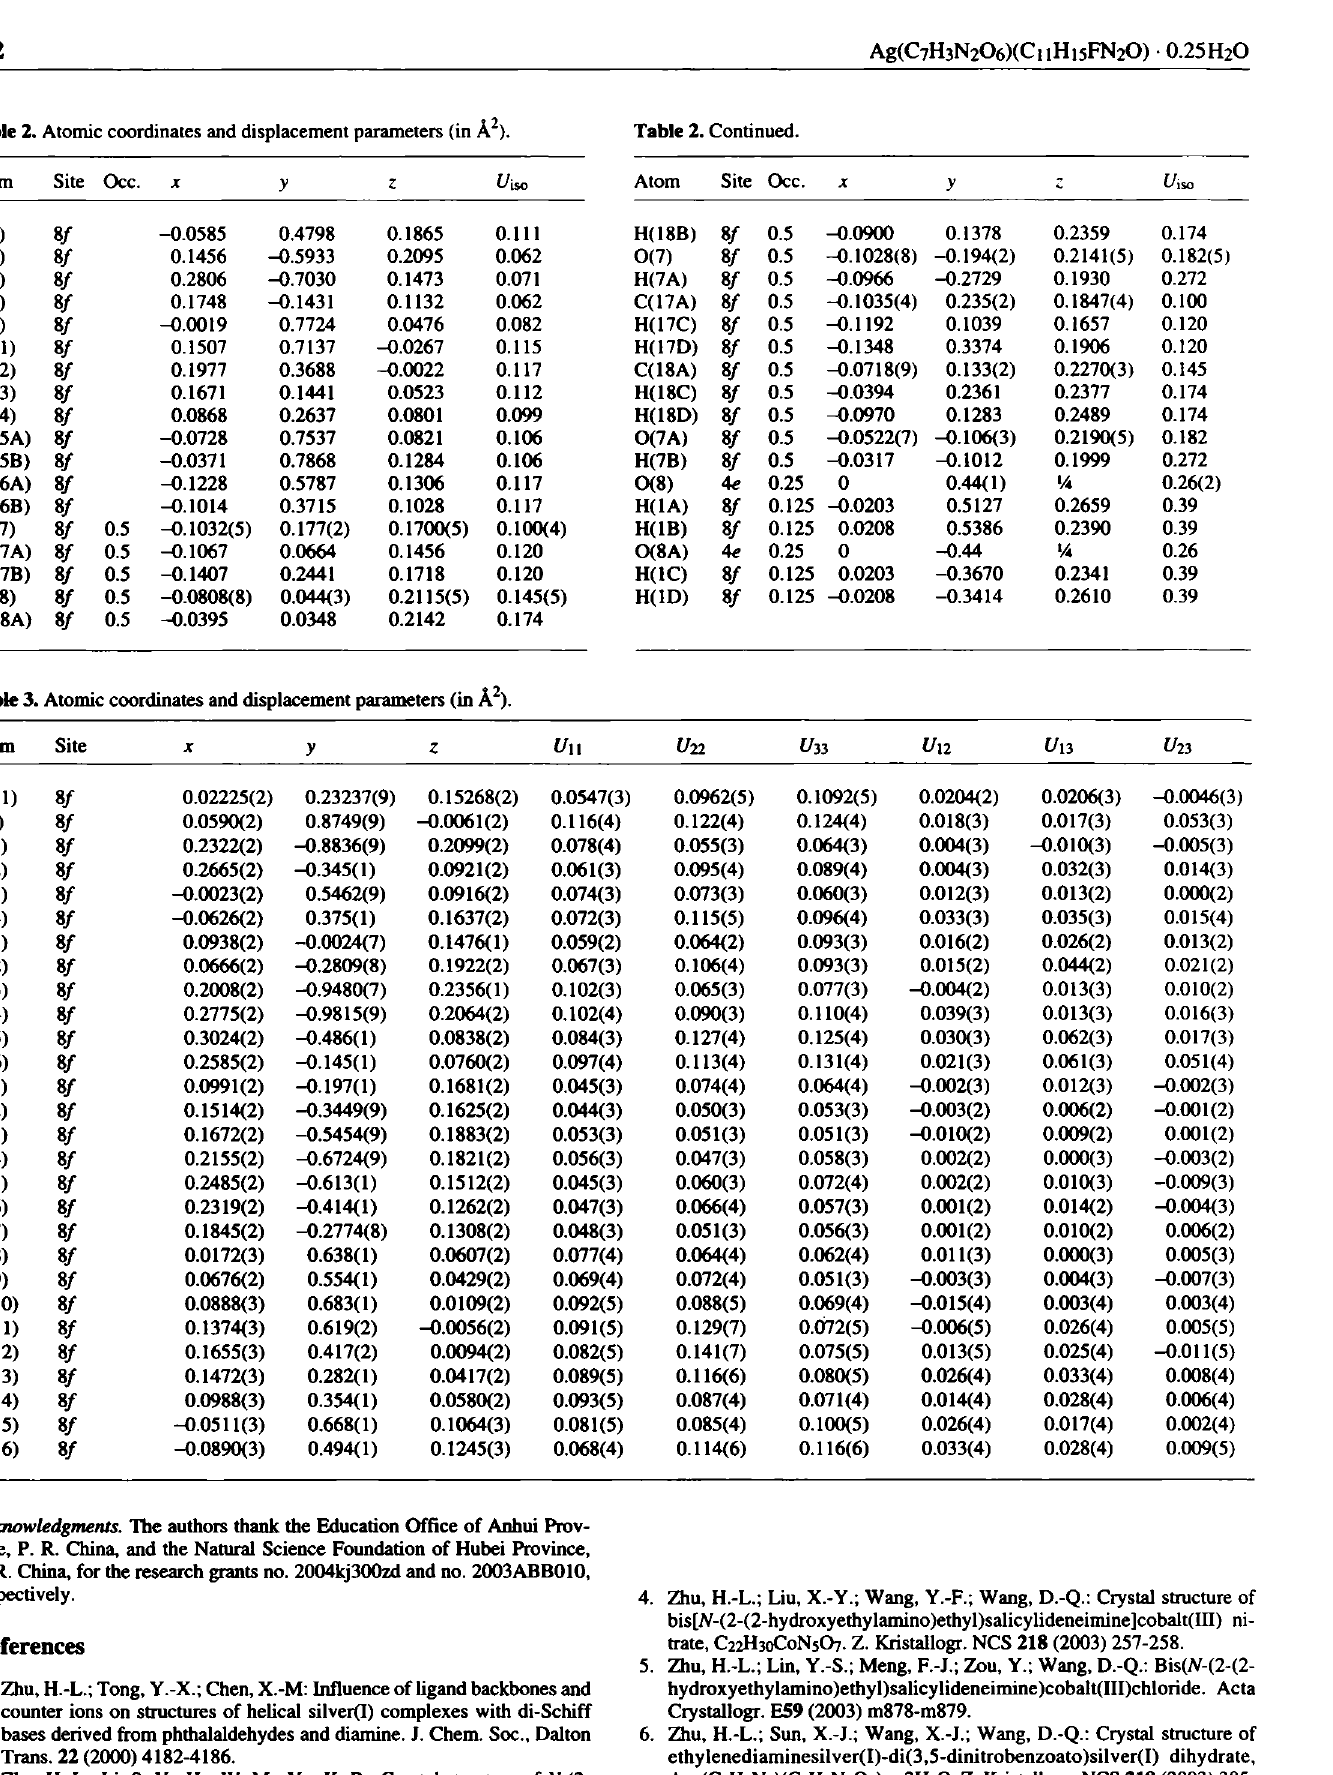
Table 2. Atomic coordinates and displacement parameters (in Â 2 ).